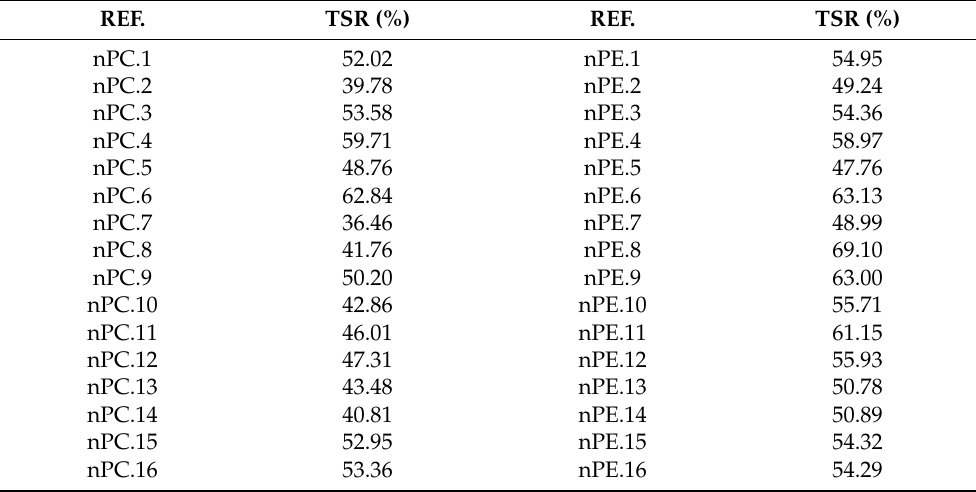
Figure 12. ( a ) TGA and ( b ) DTA diagram of laponite (L), PE original pigment and the synthesized hybrid pigments under different conditions [1–16]. ( c ) TGA and ( d ) DTA diagram of laponite (L), PE original pigment and the synthesized hybrid pigments under different conditions [1–16]. Table 5. TSR (%) Values from the PC and PE hybrid pigments under different conditions [1–16].